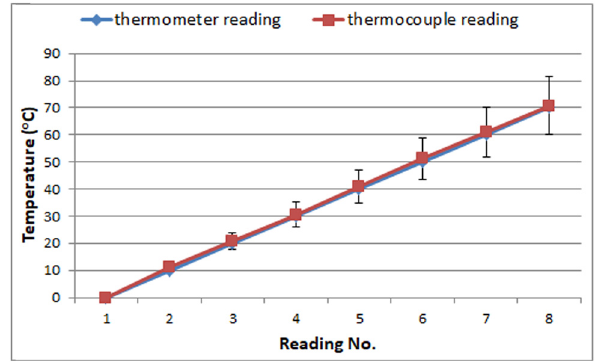
Figure 4: Calibration for thermocouple.